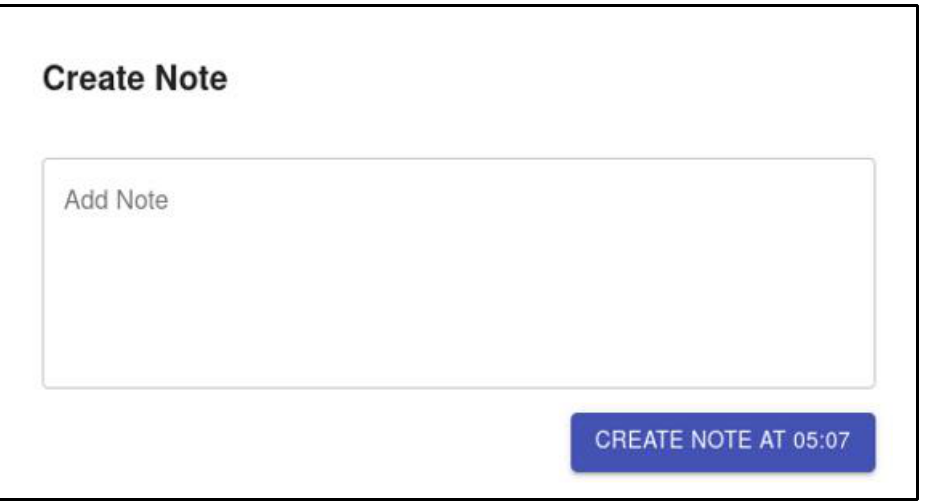
Figure 11: Note Creation Modal shows, and allows the teacher to type a message and save the note.